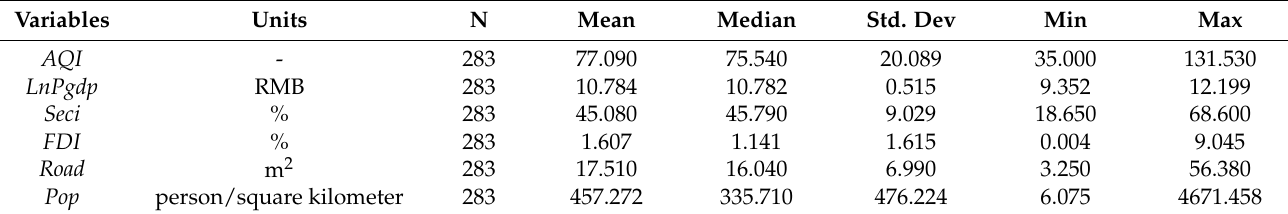
Table 3. Descriptive statistics of dependent and independent